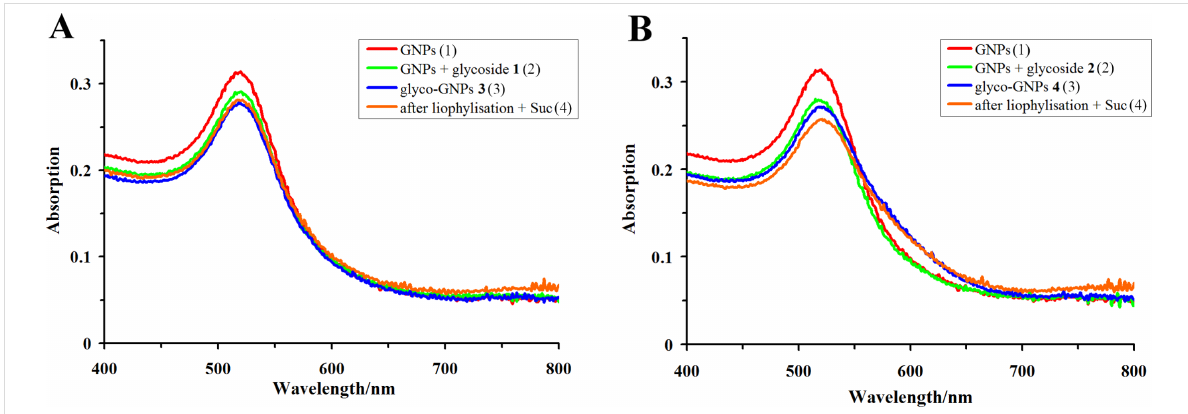
Figure 4: Spectra of (1) the solution of the starting GNPs prepared in water, (2) a mixture of solutions of GNPs (pH 9.7) and aqueous solutions con- taining 100 μ g·mL − 1 of Ara 6 glycosides 1 (A) and 2 (B) (these mixtures were used for immunization; 0.9% NaCl was additionally present in the sam- ples of these mixtures used for recording the spectra), (3) solutions of glyco-GNPs 3 (A) and 4 (B) prepared in water from glyco-GNPs 3 or 4 , which were purified from the excess of Ara 6 glycosides 1 and 2 by centrifugation of the mixtures of GNPs with glycoside solutions (see (2)), and (4) solu- tions of glyco-GNPs 3 (A) and 4 (B) prepared in 0.9% aqueous NaCl from glyco-GNPs 3 or 4 , which were purified by centrifugation, dissolved in 5% sucrose (Suc) solution and then lyophilized.